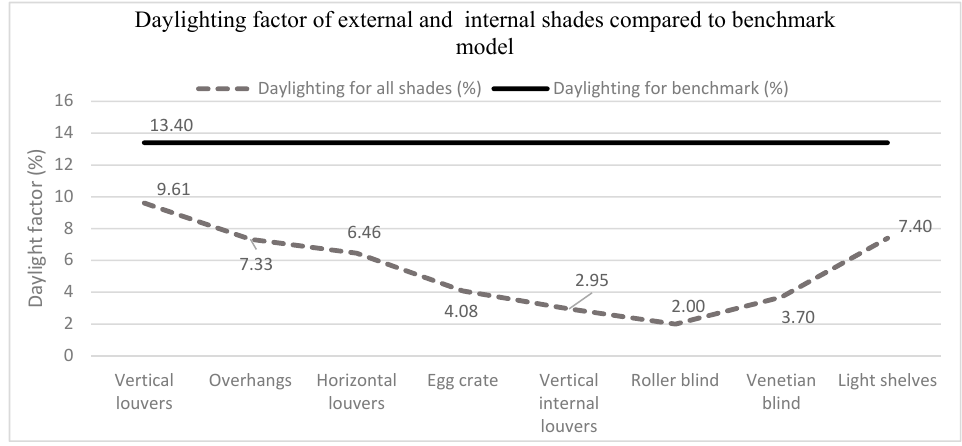
Figure 7. Comparison between benchmark and external and internal shades for daylighting factor levels.